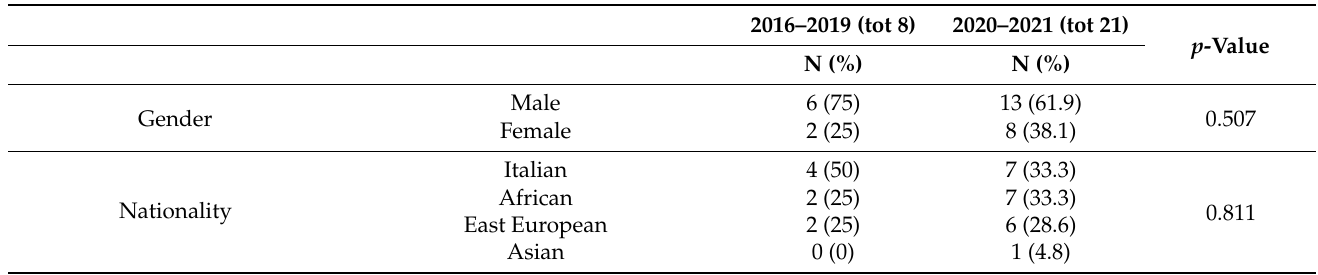
Table 1. Baseline and clinical characteristics of TB patients with PTE, January 2016 − December 2021 ( n =